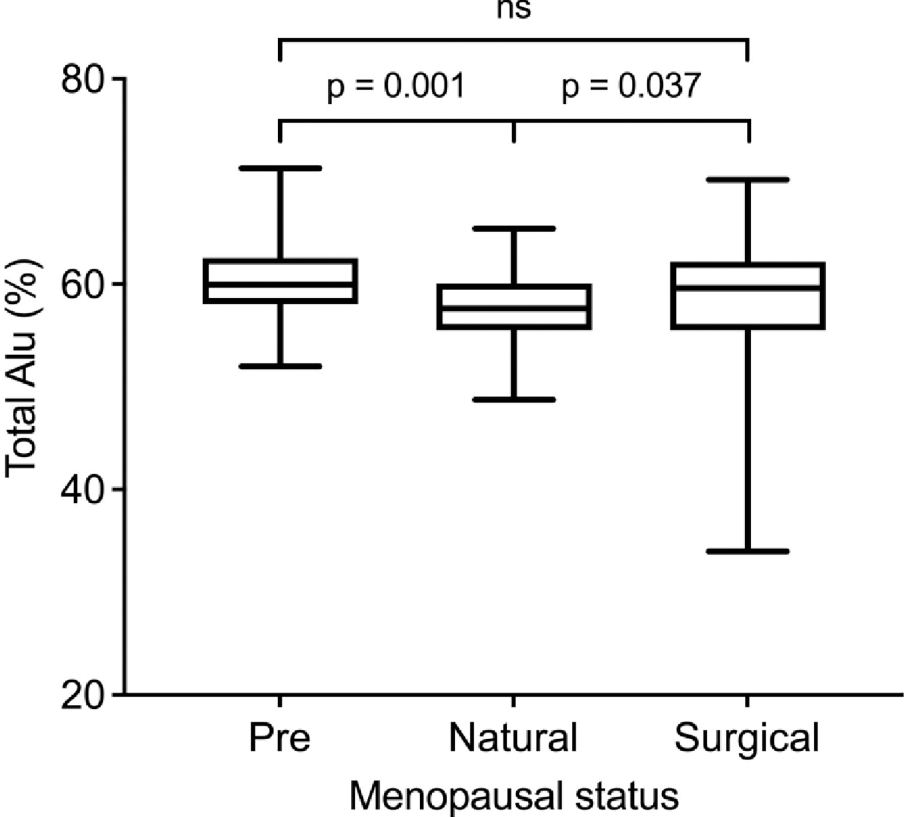
Fig 1. Variation in the total Alu level (%) with menopausal status. Dunn’s post-hoc test showing differences in the total Alu level. Statistical significance was set at p < 0.05.